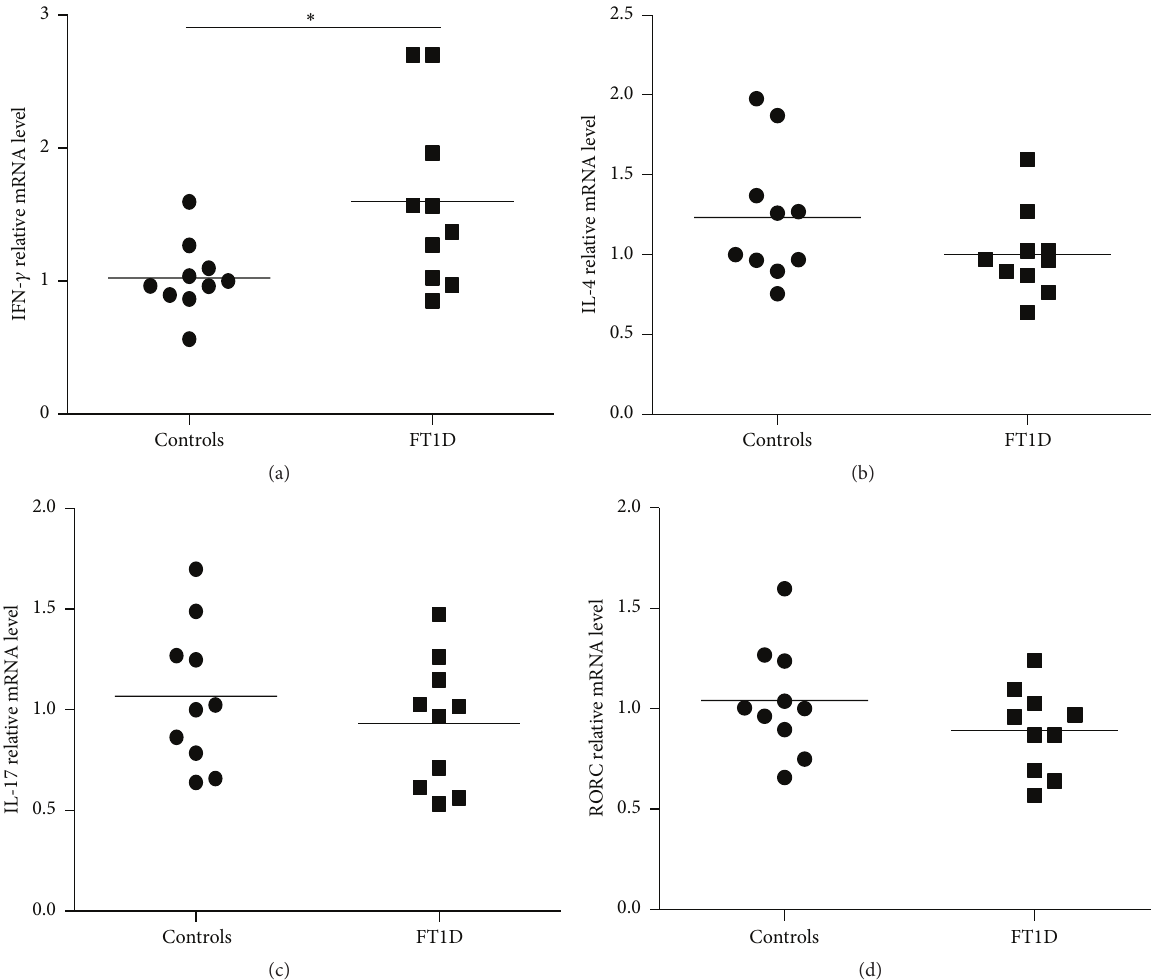
Figure 2: IFN- 𝛾 expression levels are increased in PBMCs from patients with FT1D. Relative mRNA levels for IFN- 𝛾 , IL-4, IL-17, and RORC in PBMCs from FT1D and healthy controls ( 𝑛 = 10 ). The expression levels were normalized by GAPDH. Data plotted represent expression levels in PBMCs of control subjects (closed circles) and FT1D patients (closed